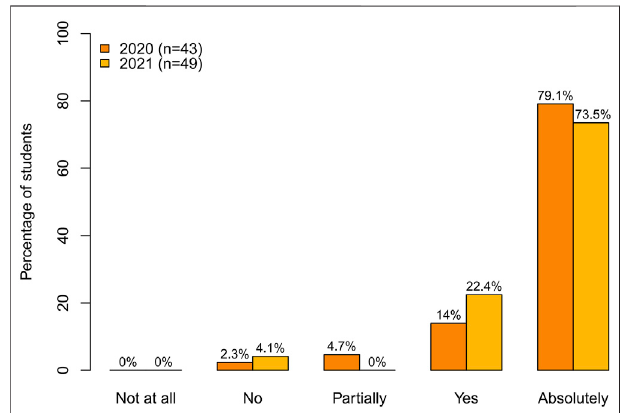
FIGURE6| Agreementwiththestatement “ Theexcursionfeltdifferentto our normal studies ” . Almost all students considered the excursion to be very different from the usual study setting (results from the survey sent out in fall 2021, 5 and 17 months after the excursion,